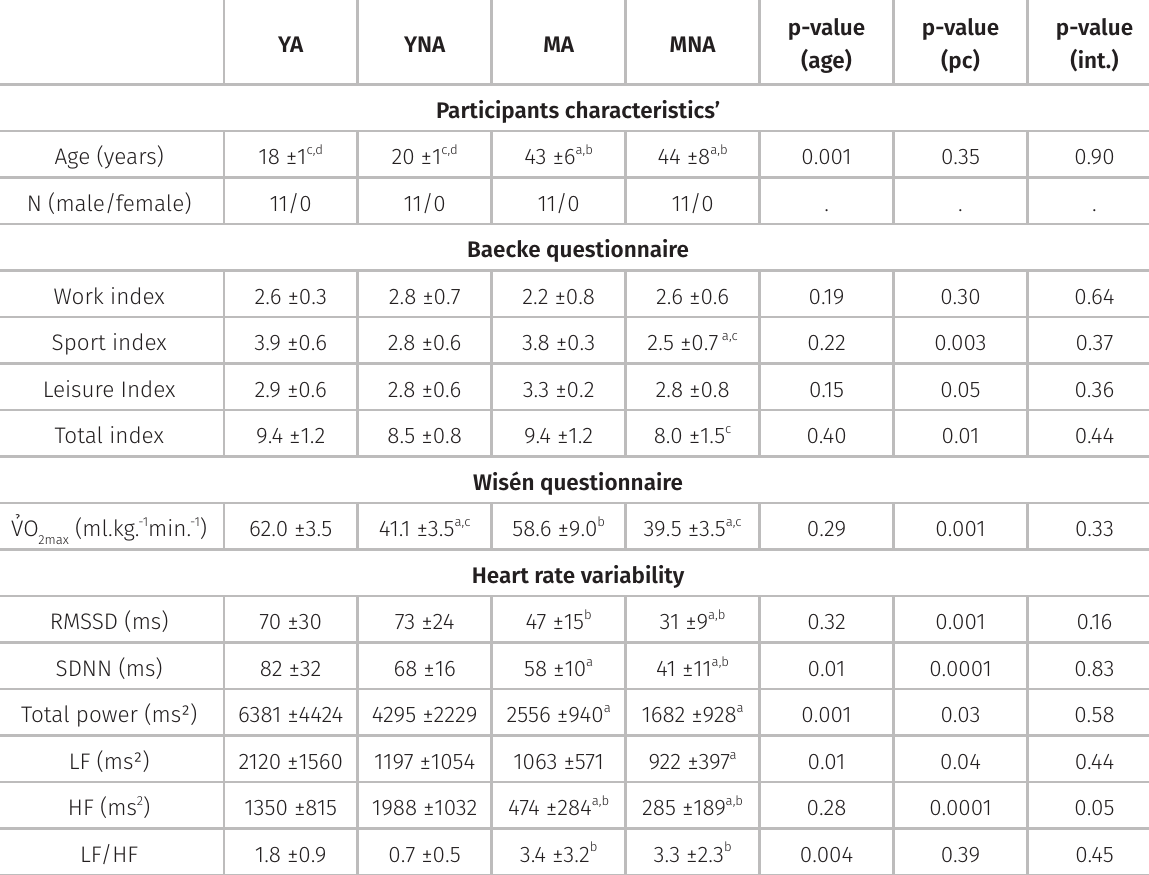
Table I. Comparison of cardiac autonomic modulation in the supine